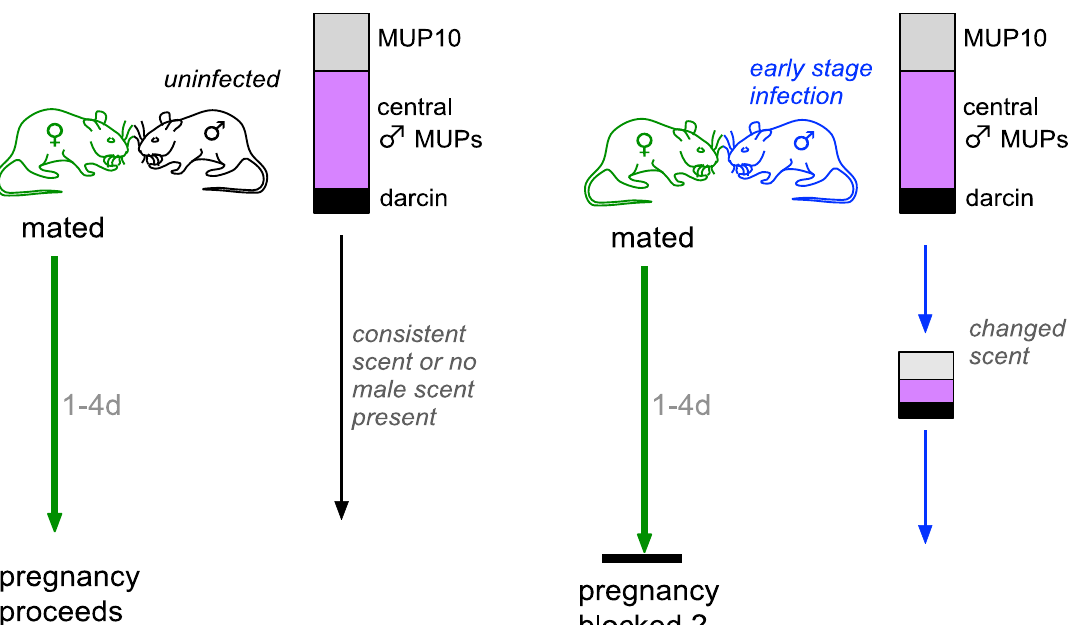
Figure 7. A putative model for the potential of LCMV to elicit pregnancy block (the Bruce effect). LCMV can be transmitted via semen and other excreta from infected mice. Females learn the scent signature of their mate in response to vaginocervical stimulation during mating. Males that are not infected with LCMV (black mouse) produce a strong and consistent signature of MUPs and associated ligands. Detection of consistent mate’s scent (or no male scent) over first 3 days post mating protects against implantation failure and pregnancy proceeds. Males at an early stage of LCMV infection during viral replication (blue mouse) initially produce strong MUP signals that rapidly become suppressed (also changing the profile of bound ligands). Exposure to changed scent of mate over first 4 days post mating in the absence of the remembered mate’s scent is predicted to inhibit prolactin release and leads to pregnancy failure. Bars indicate the amount of darcin (black), male-biased central MUPs (purple) and central MUP10 (grey) produced by males (data are mean mg MUP / mg creatine produced by singly housed C57BL/6 males in this study). See text for further details.